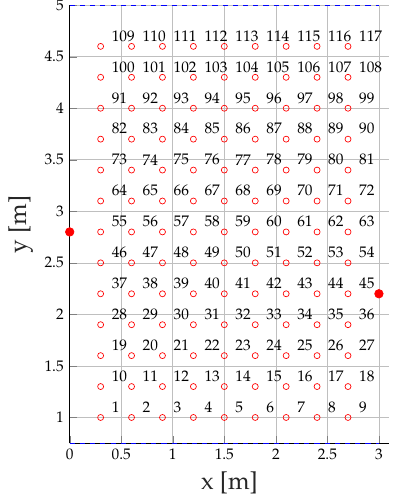
Figure 6. Measurement